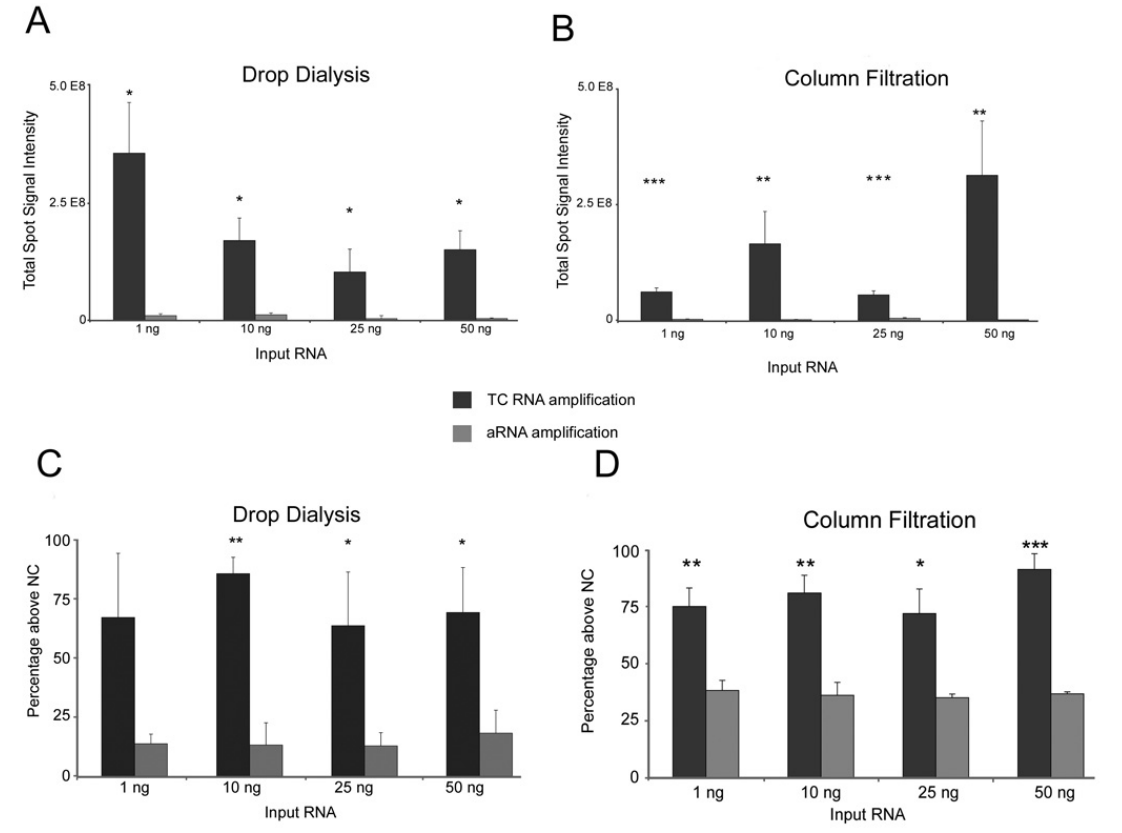
Figure 5. TC RNA amplification and aRNA amplification following drop dialysis (A, C) and column filtration (B, D) as a function of hybridization signal intensity (A, B) and percentage above negative control (NC) values (C, D). Single asterisk denotes (p < 0.05), double asterisk denotes (p < 0.01), and triple asterisk denotes (p <